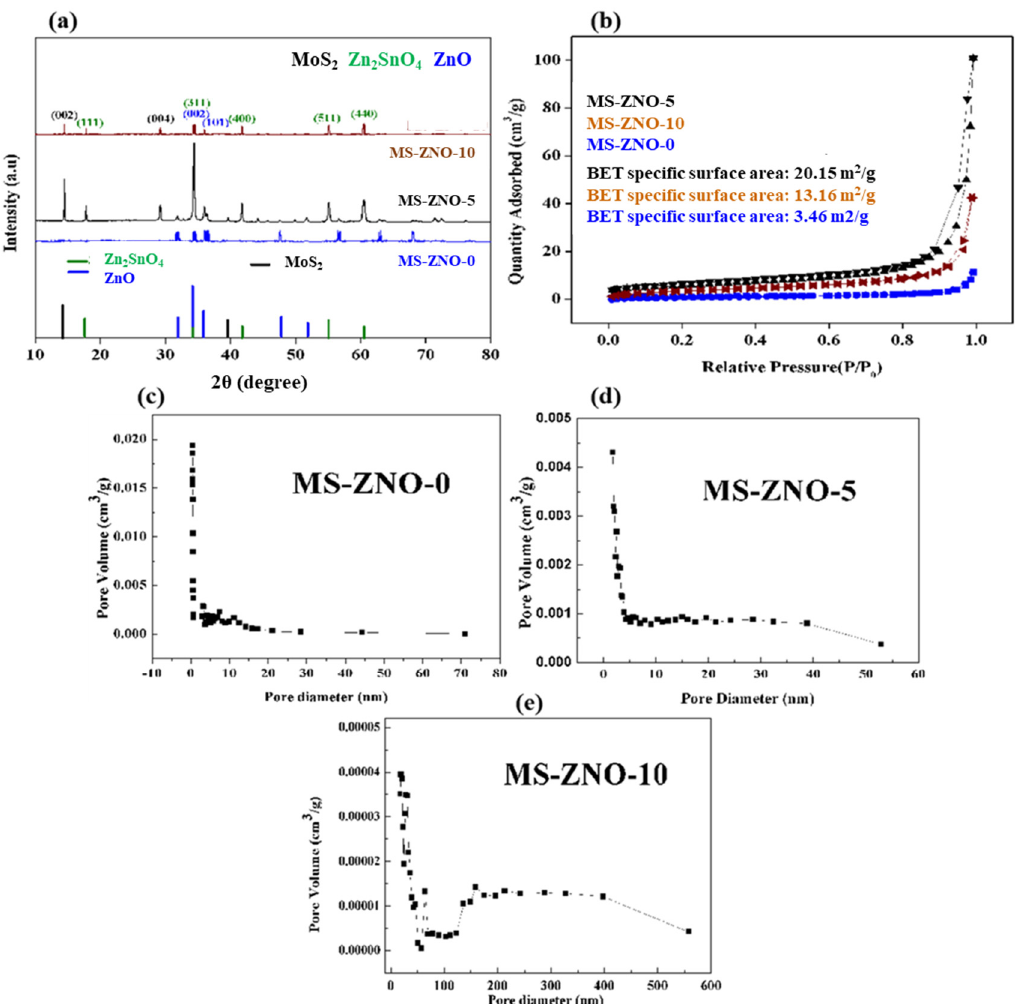
Figure 1. ( a ) XRD patterns; ( b ) N 2 adsorption–desorption isotherms; ( c ) pore size distribution of MS − ZNO-0; ( d ) pore size distribution of MS − ZNO − 5; ( e ) pore size distribution of MS − ZNO − 10.